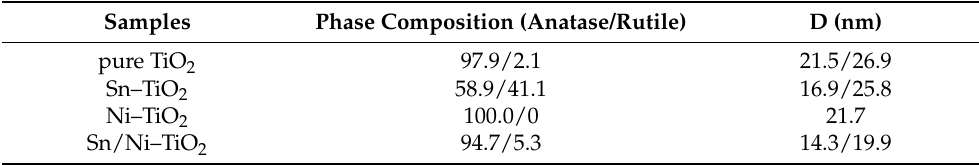
Figure 1. XRD patterns of samples. Table 1. Phase composition and Crystallite size (D) of samples.